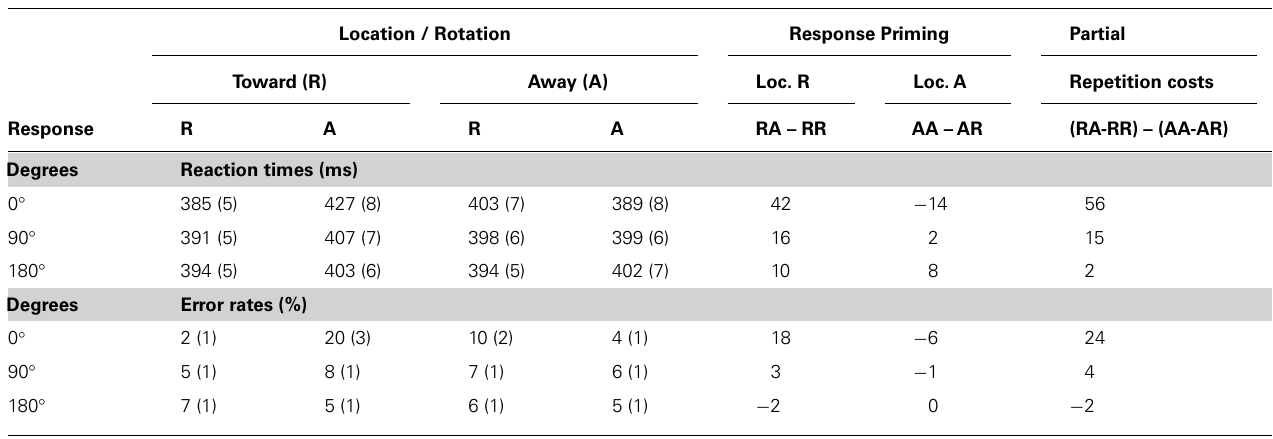
Table 2B | Experiment 2, response-priming and Event-file